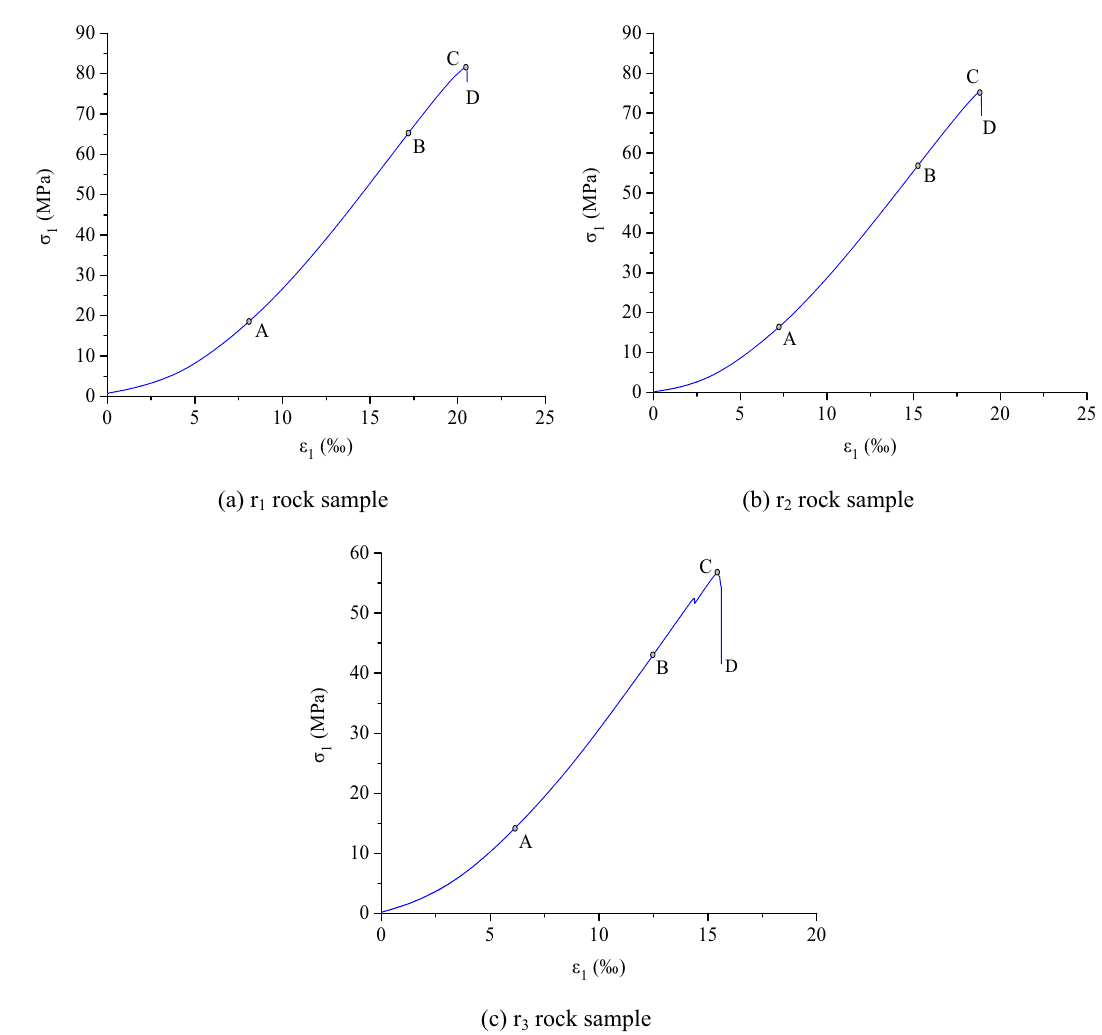
Fig. 4 Complete stress–strain relationship curve of sandstone Table 1 Basic mechanical parameters of each coal and rock